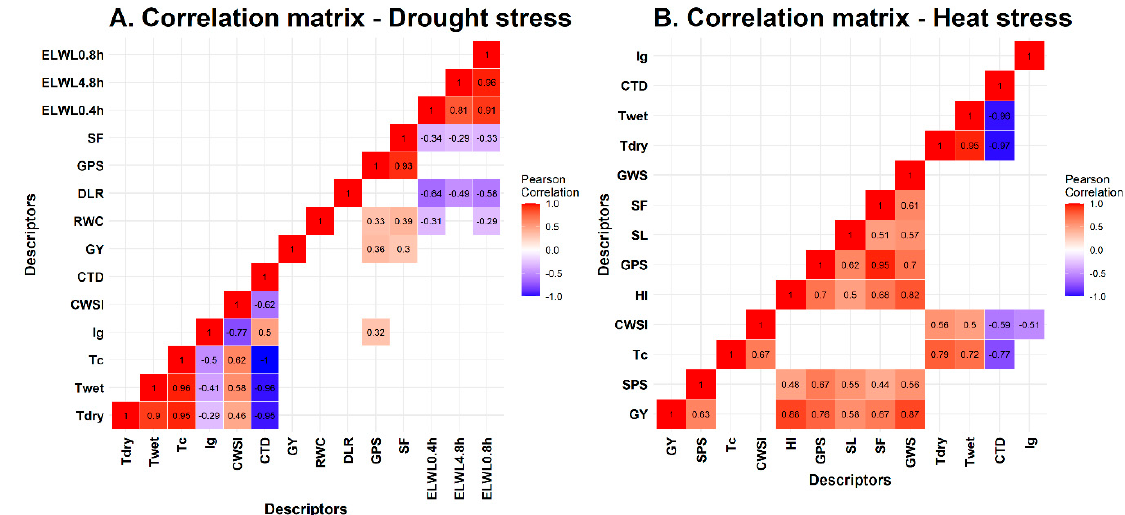
Figure 6. Correlation matrix plots for the drought and heat stress related traits recorded for ( A ) drought and ( B ) heat stress experiments. ( A ) drought and ( B ) heat stress experiments.